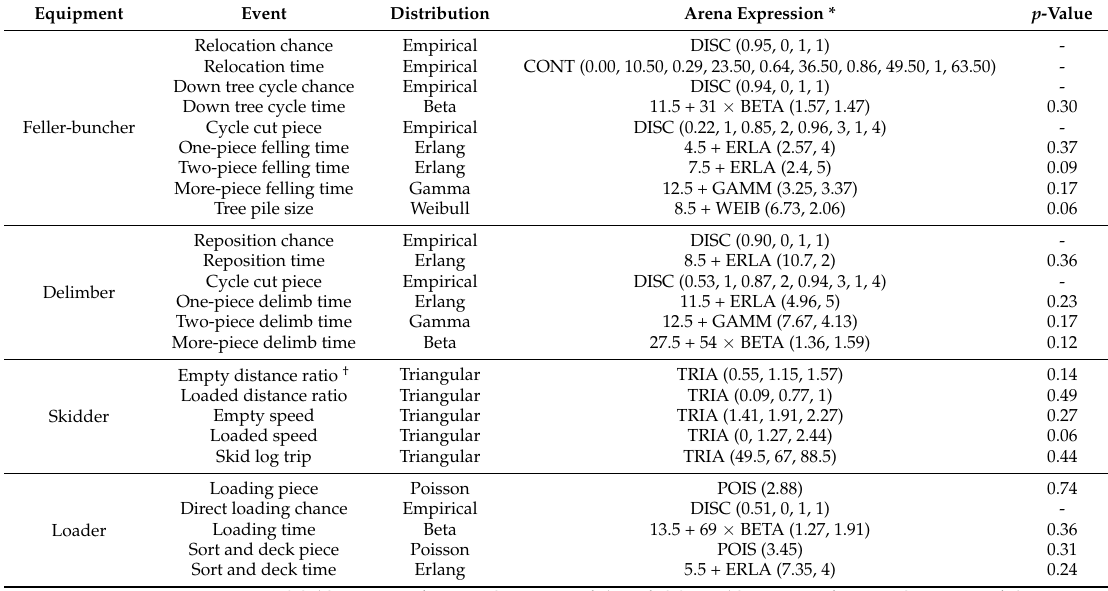
Table 3. Fitted distributions for each event of machine